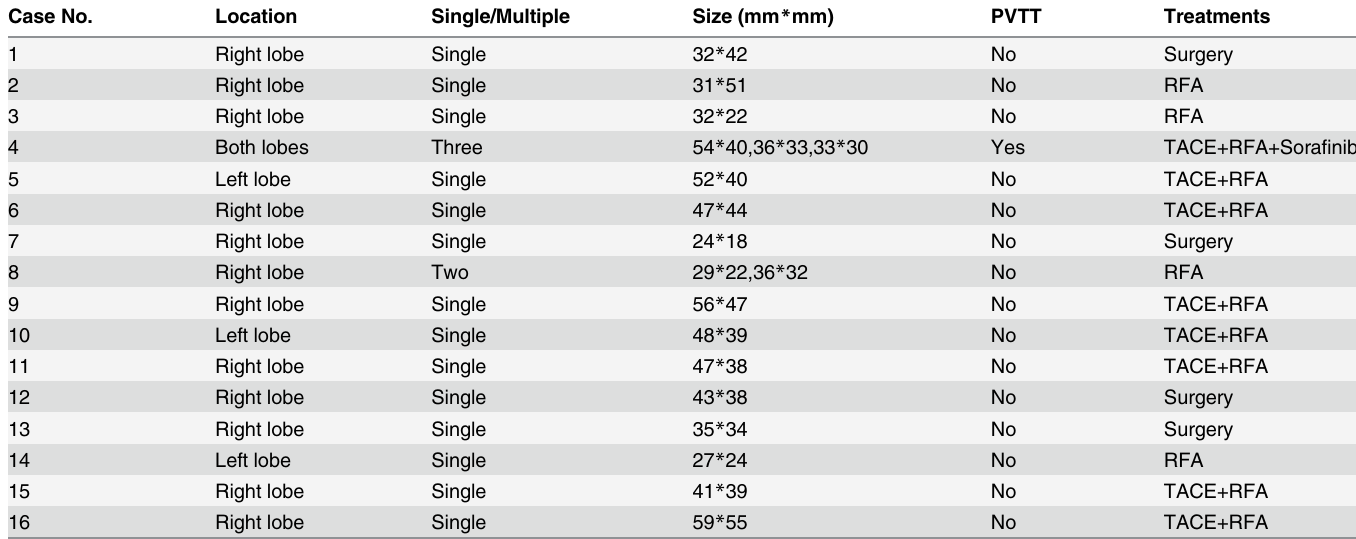
Table 4. Characteristics of the hepatic